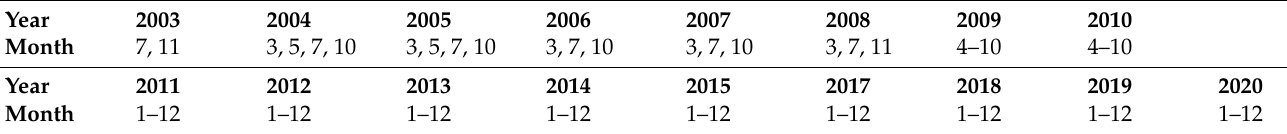
Table 3. Frequency of in situ water sampling for determination of OP concentration near the D-6 oil